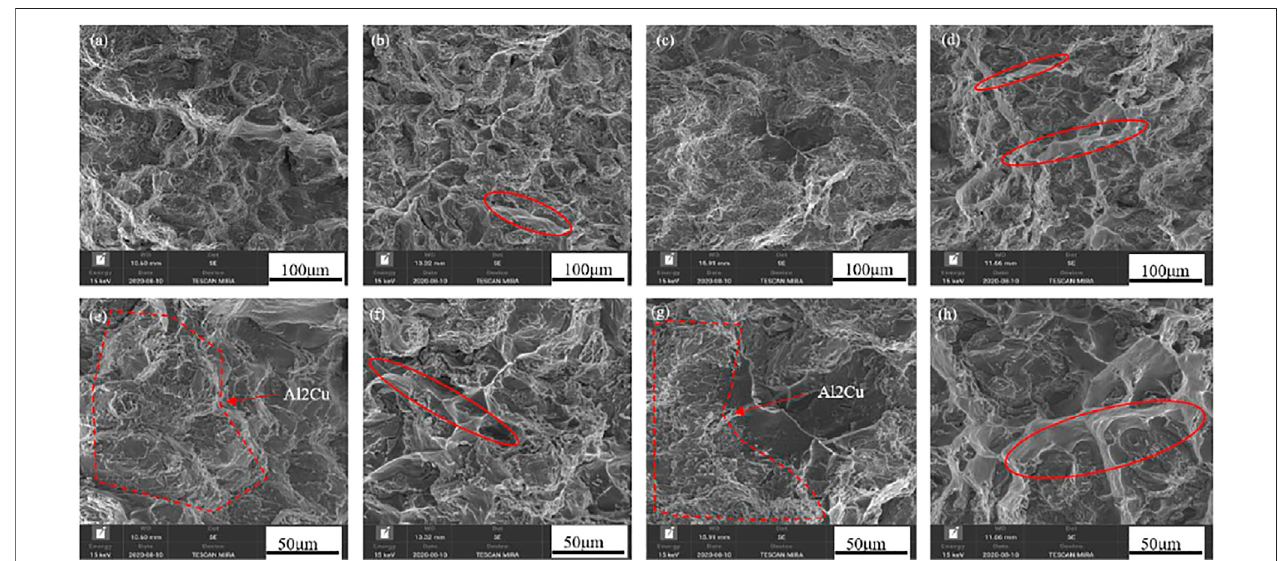
FIGURE 11 | Fracture morphology: (A, E) the center part, and (B, F) the edge part in the ingot with the TSU; (C, G) the center part, and (D, H) the edge part in the ingot with the DSU.